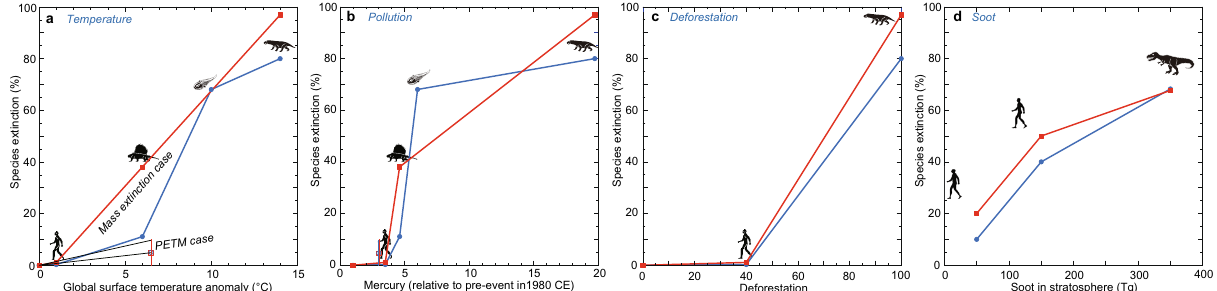
Figure 1. Relationships between the four causes of mass extinctions and the species extinction magnitude. The causes include global surface temperature anomalies 4 ( a ), mercury amounts (relative to pre-event values) as a proxy for pollution ( b ) 10,22,29–31 , the deforestation area % ( c ) 12,18,19,24 , and the amount of soot present in the stratosphere inducing sunlight reduction and global cooling due to nuclear war in future or the asteroid impact at the K–Pg boundary ( d ) 14 (see Methods and Supplementary Table S1). Data in a – c are from the end- Ordovician, end-Guadalupian, end-Permian, and Holocene–Anthropocene, characterized by global warming and terrestrial–nearshore animal extinctions. Blue circle: marine animals. Red square: terrestrial tetrapods. Open blue circles and red squares show data at the Paleocene–Eocene Thermal Maximum (PETM), which lacks deforestation, stratospheric aerosol formation causing global cooling and a mass extinction. There are the mass extinction case and PETM case on global surface temperature anomaly ( a ). An increase in global surface temperature by 6.5 °C, which is converted from the sea surface temperature (SST) anomaly (4–5 °C) of Zachos et al . 17 using the figure of Kaiho 4 for the conversion) at the Paleocene–Eocene thermal maximum (PETM). These data are shown in Supplementary Table S1.